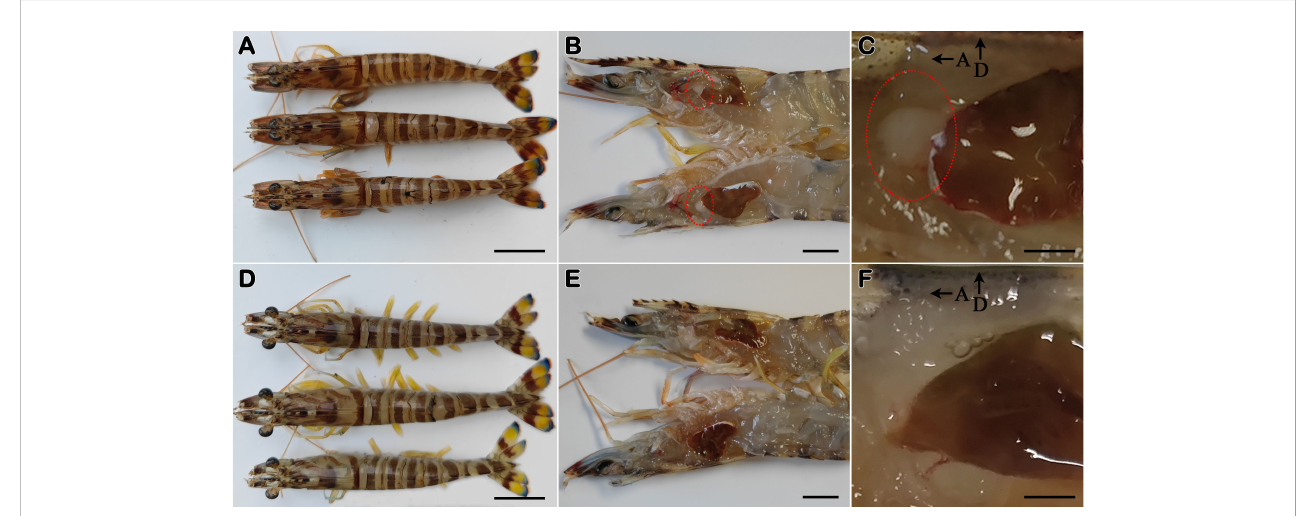
FIGURE 2 Clinical signs of Penaeus japonicus . (A – C) External appearance, central longitudinal section and close view of central longitudinal section of diseased individuals (from PO and IM groups); (D – F) External appearance, central longitudinal section and close view of central longitudinal section of healthy individuals (from CPO and CIM groups). Red circle: whitish lymphoid organ; A: toward the anterior region of the shrimp; D: toward the dorsal region of the shrimp. Bar, 20 mm (A, D) ; 10 mm (B, E) ; 2 mm (C, F)